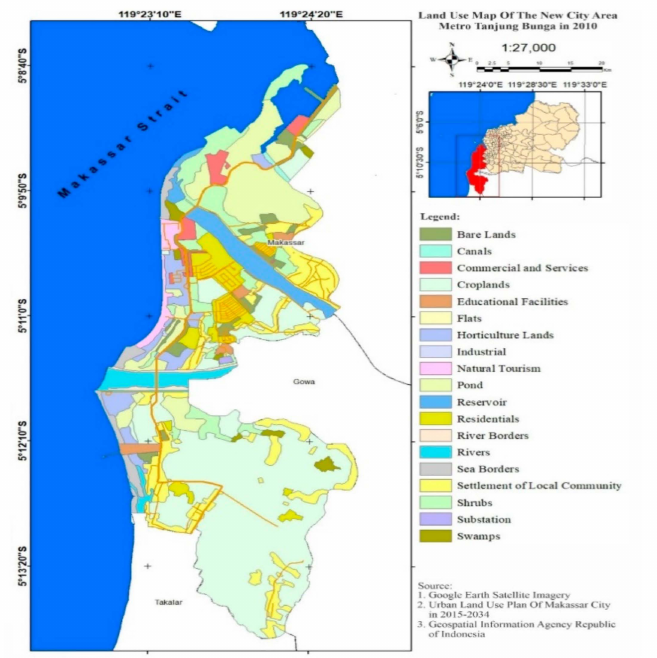
Figure 8. Utilization of space in the new city area of Metro Tanjung Bunga in the period 2010–2013. Source: Author